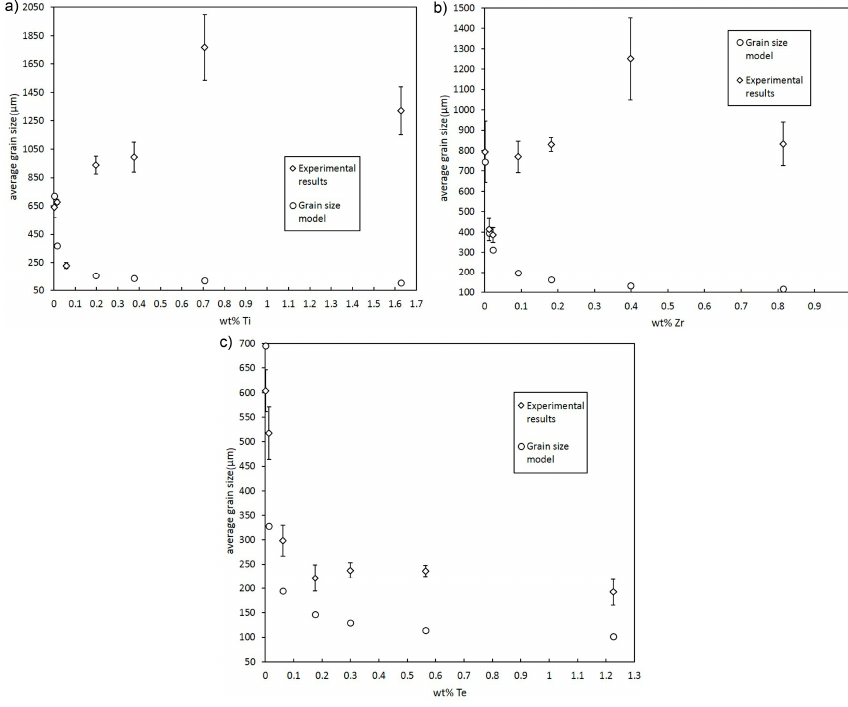
Figure 4. Grain size of Cu with a range of Ni ( a ), Bi ( b ) and Cr ( c ) concentrations.